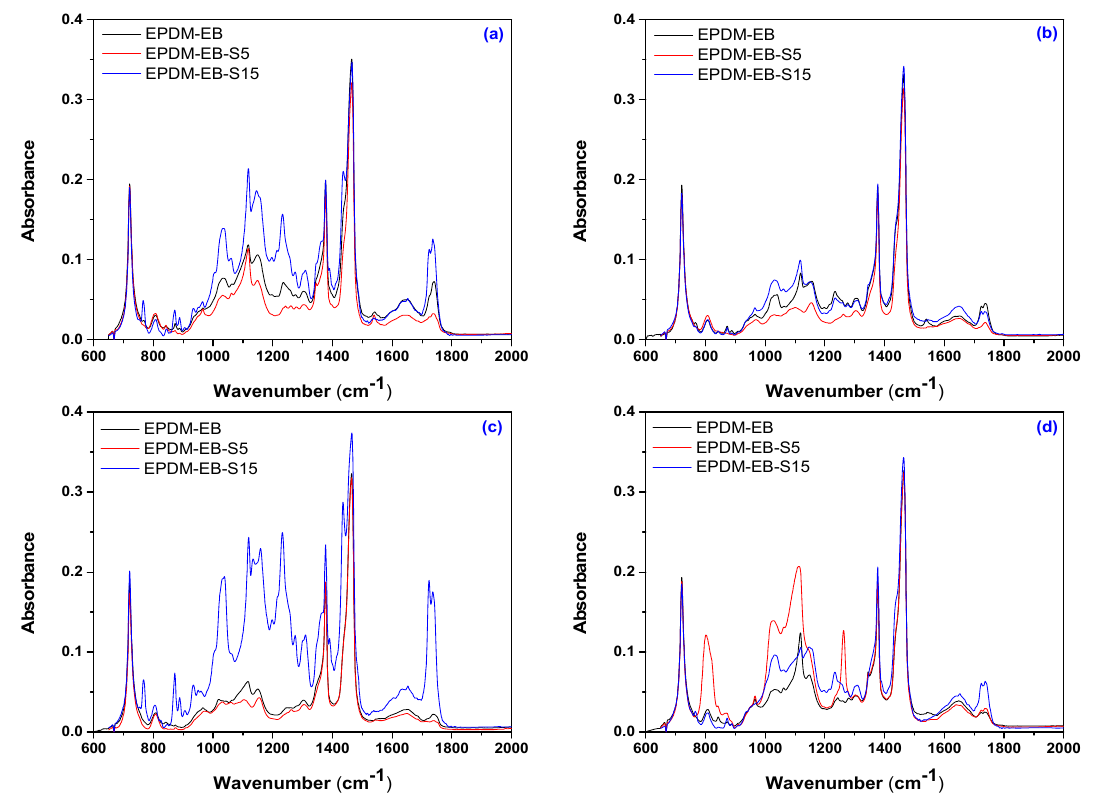
Figure 9. FTIR spectra of EPDM-EB-S composites cross-linked by EB irradiation at 75 kGy ( a ), 150 kGy ( b ), 300 kGy, ( c ) and 600 kGy ( d ) in the range of 650–2000 cm − 1 .